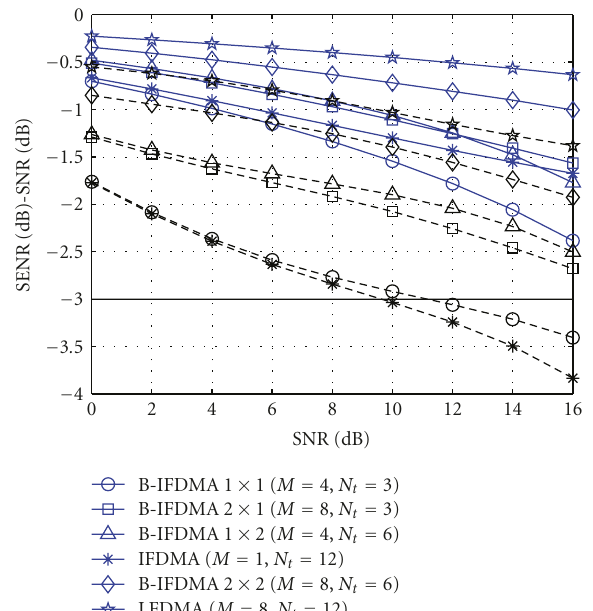
Figure 8: Performance degradation in dB due to imperfect channel estimation versus ideal SNR. The vertical axis shows the di ff erence between actual perceived signal-to-estimation-error-plus noise ratio (SENR, in dB) and ideal SNR (in dB). The horizontal axis shows the ideal SNR, that is, assuming perfect channel state information. For example, the value − 3 on the vertical axis means that a bit-error-rate curve generated in an idealized setting where perfect channel estimation is assumed should be displaced 3 dB to the right to correctly represent performance when the influence of channel estimation is taken into consideration. Solid curves represent (optimal) smoothed Kalman filter performance. Dashed curves represent Wiener filter performance, where no previous measurements are used by the